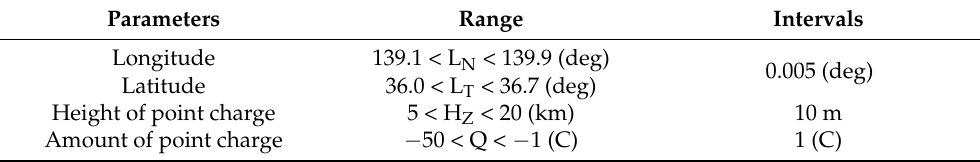
Table 2. Setting of grids to calculate the surface electrostatic field at each station. Parameters Range